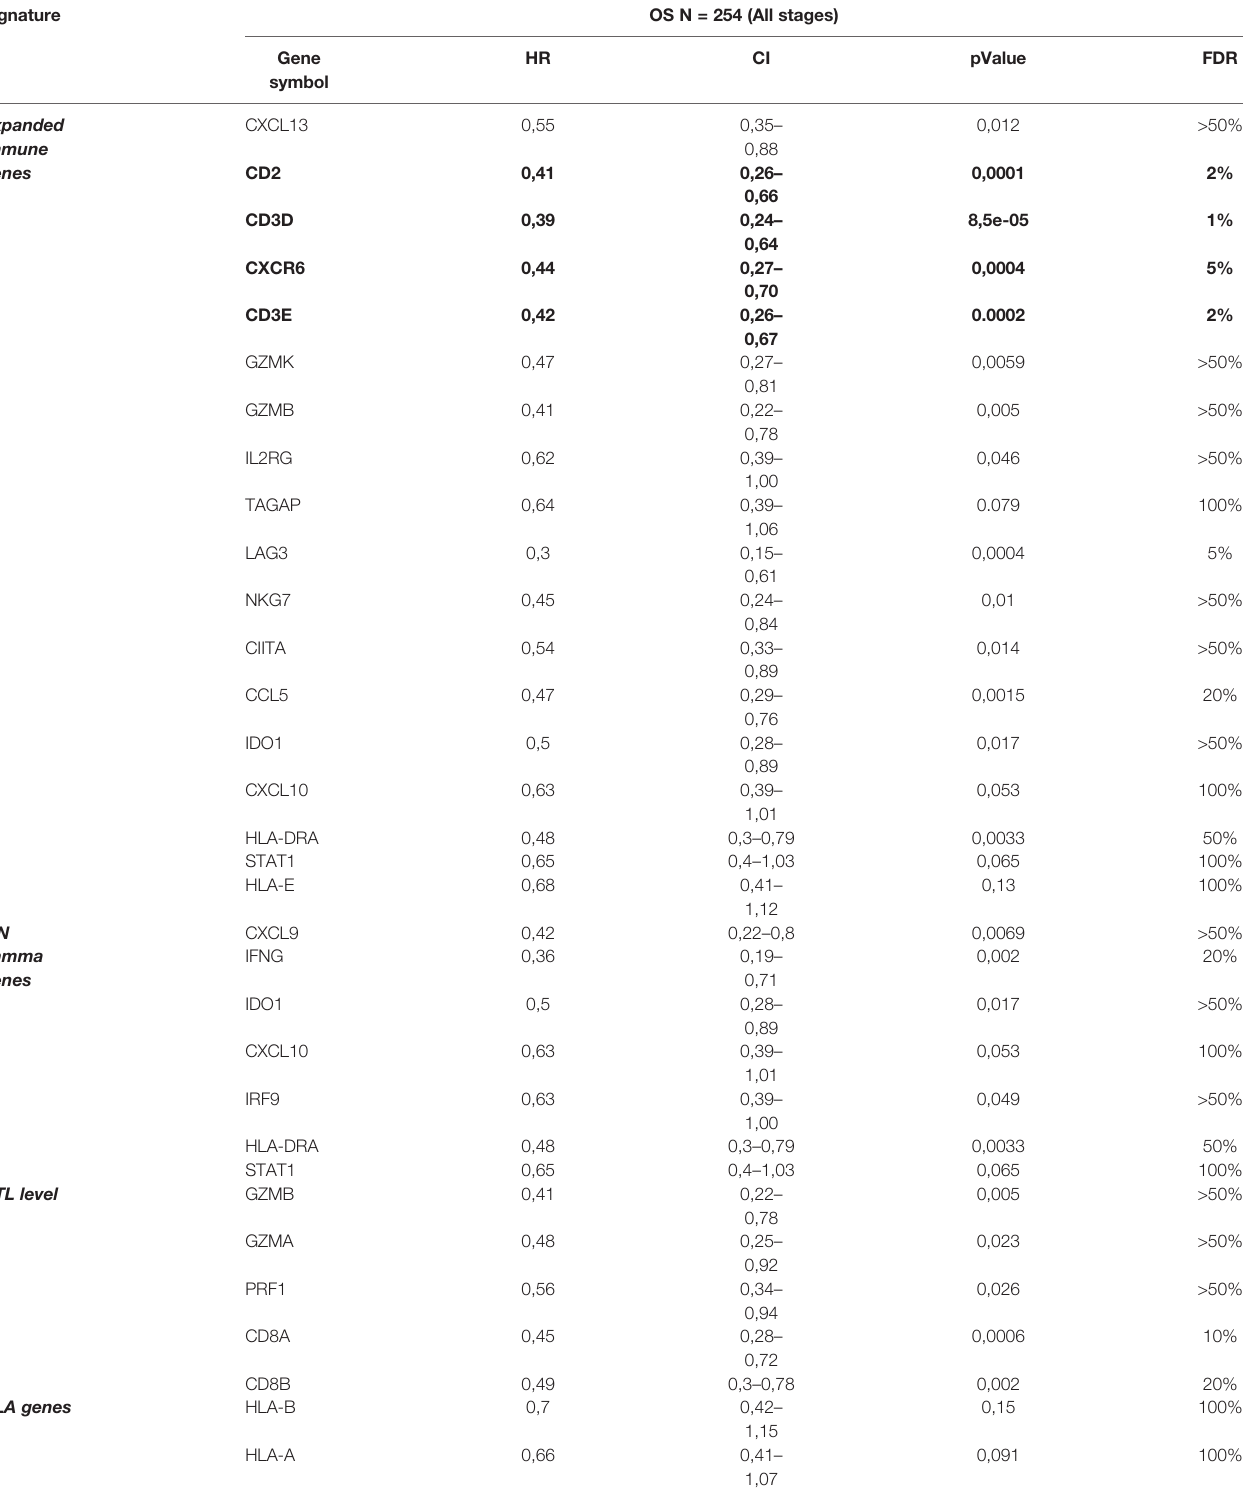
TABLE 5 | Clinical outcome of individual immune genes from the four immune gene signatures in terms of overall survival (OS) of CSCC